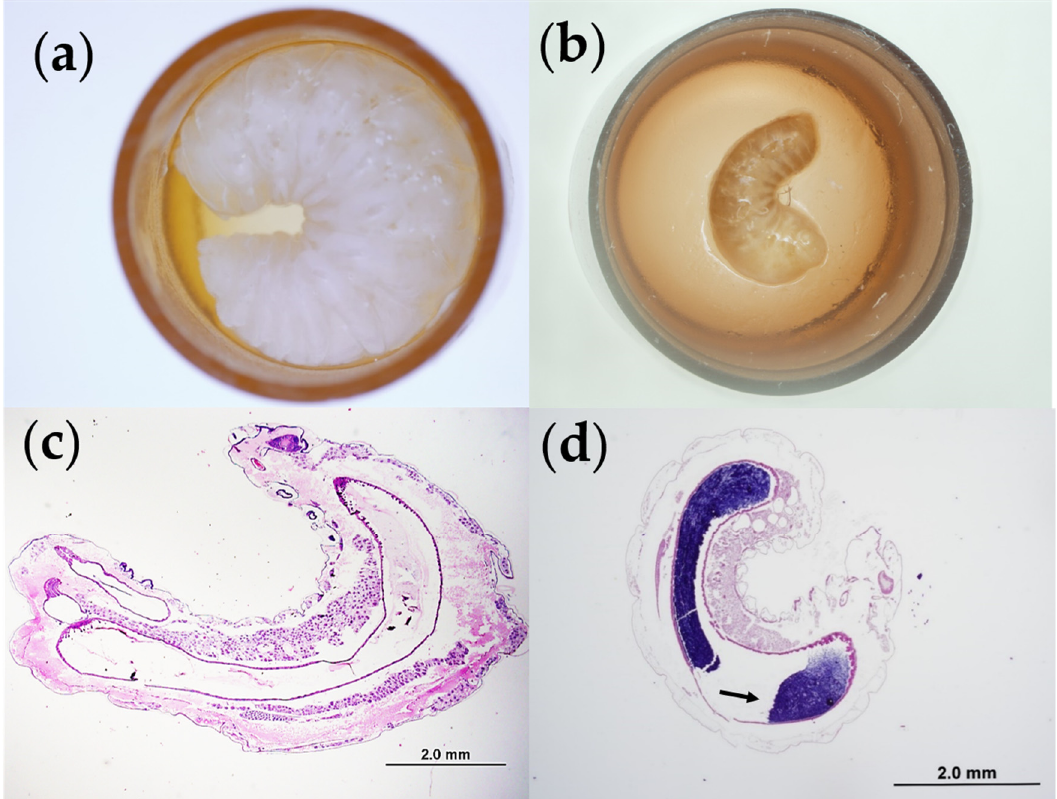
Figure 1. In vitro multiplication of Melissococcus plutonius in honeybee worker larvae. Gross ( a ), ( b ) and histologic sections ( c ), ( d ) after 6 days of in vitro rearing of control larvae ( a ), ( c ) and larvae infected with M. plutonius ( b ), ( d ). The healthy control larvae ( a ) is white and plump compared to the larvae infected with M. plutonius ( b ), which is decreased in mass, brown and deflated, with prominent tracheae. The Gram-stained section of an infected larva ( d ) demonstrates a mass of gram-positive bacteria (arrow) within the midgut which is absent in the section of a control larva stained with Hematoxylin and Eosin ( c ).